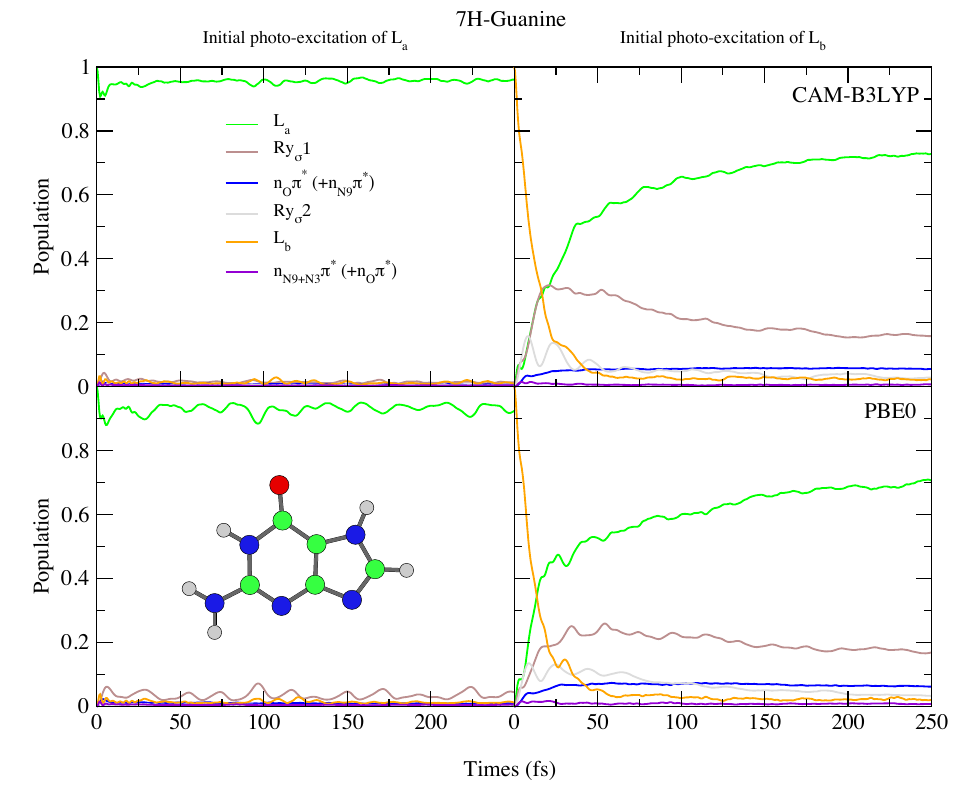
Figure 11. Nonadiabatic dynamics of electronic populations of 7H-Guanine in the gas phase, as predicted by an LVC Hamiltonian parameterised with calculations using CAM-B3LYP ( top ) and PBE0 ( bottom ) functionals with 6-311+G(d,p) basis